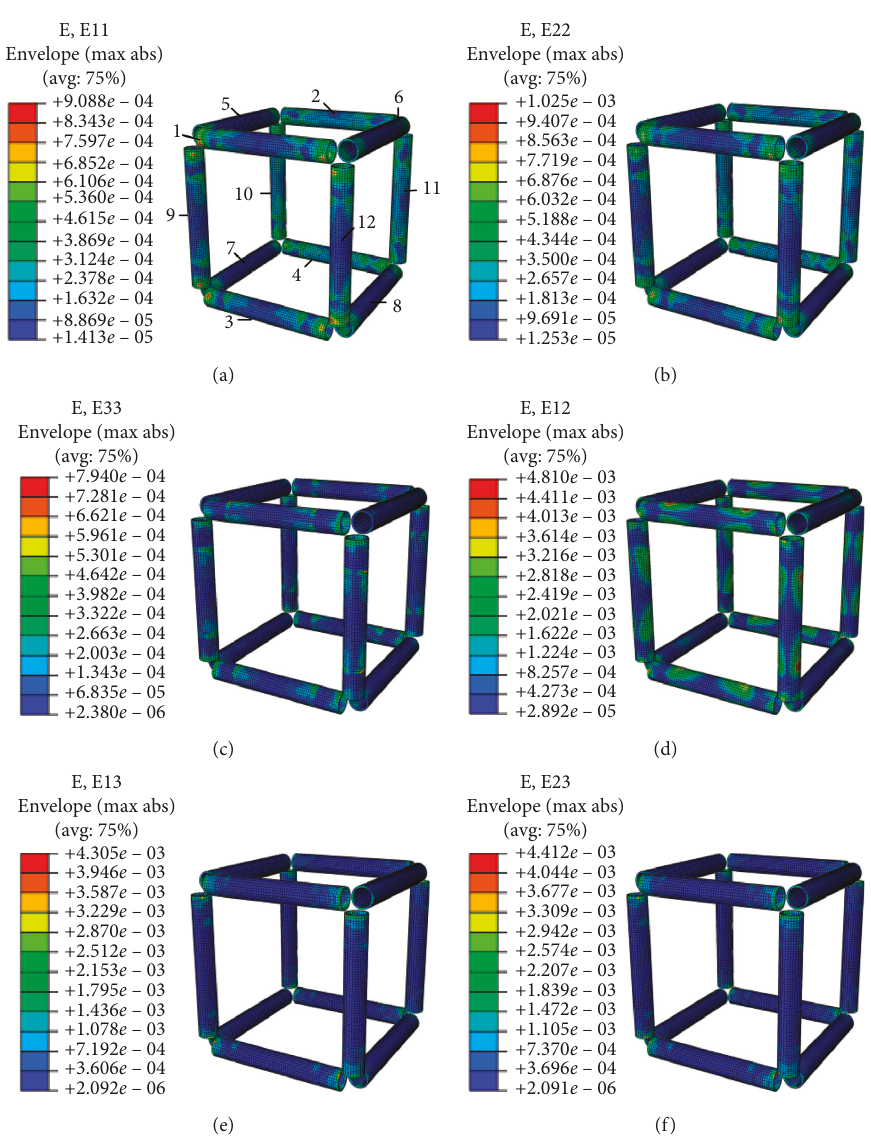
Figure 2: Strain cloud diagram of CFRP truss elements. Strain component in directions (a) 11, (b) 22, (c) 33, (d) 12, (e) 13, and (f)